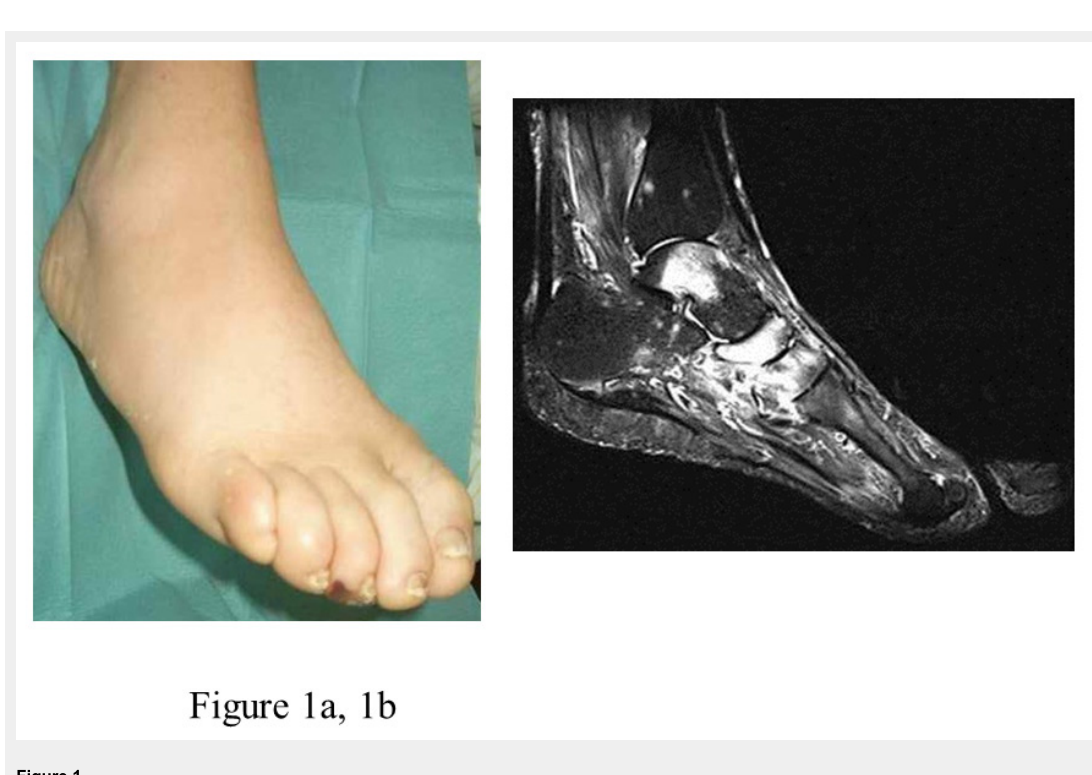
a: clinical aspect of an acute Charcot foot stage 0. b: MRI (T2w, fat suppressed) showing marrow oedema in the talus, and the navicular and cuneiform bones plus adjacent soft tissue oedema (bright